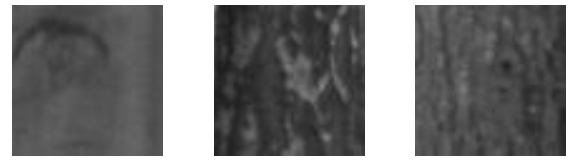
Figure 1. 60x60px boxes of tree bark of different tree